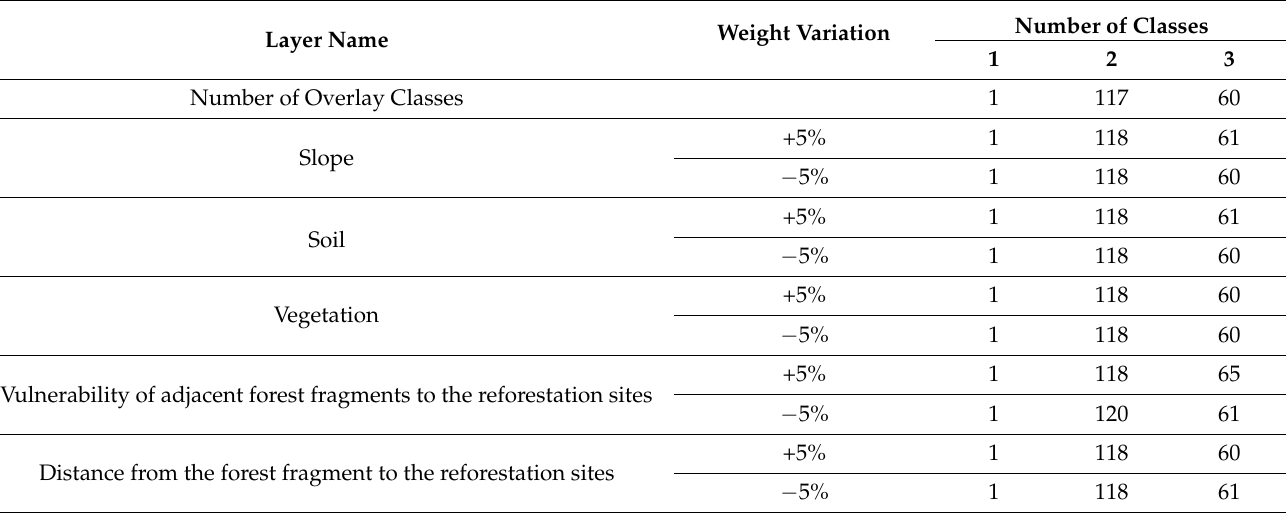
Table 6. Sensitivity